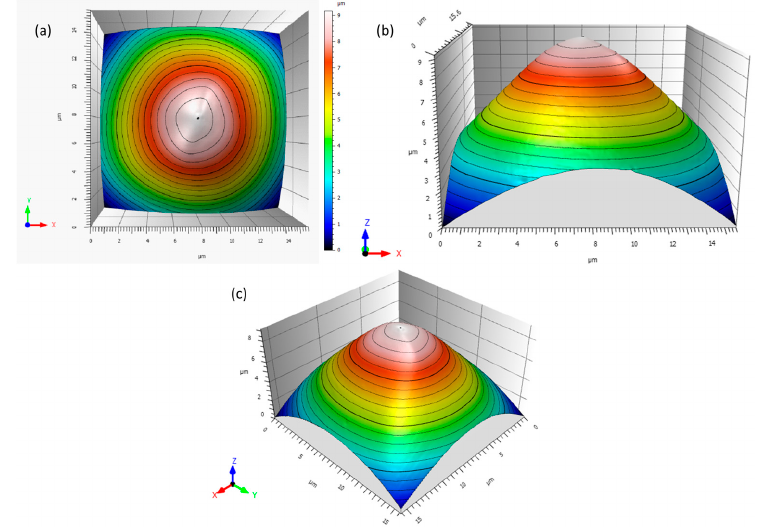
Figure 30. Renderings of the imperfect tip geometry obtained when a cono-spherical tip was purchased from Micro Star Technologies: ( a – c ) have been normalized in the x, y, and z directions. ( a ) Demonstrates the degree of deviation of the actual tip geometry from an ideally spherical tip at the apex of the indenter probe. Notice the scale bar in microns to the right of ( a ), which topographically signifies the distance from the point of Cartesian coordinate origin parallel to an x-y plane that is orthogonal to the z axis.